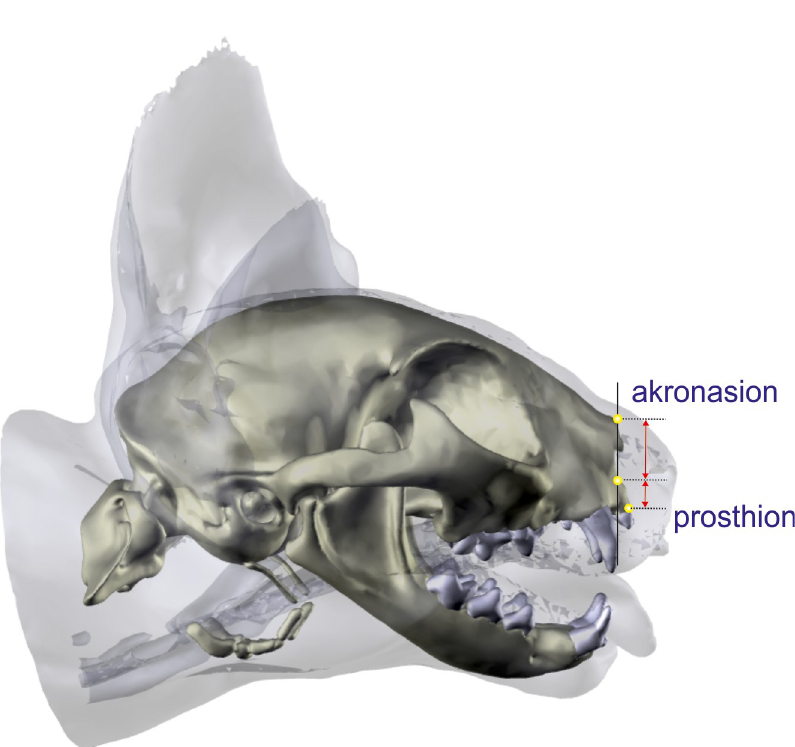
Fig 4. Measurements of the relative height of the bony nasal aperture. Three-dimensional reconstructions of a Domestic shorthair cat in a lateral view. The distance from the akronasion to the midpoint of the palatine process of the incisive bone compared with the distance from the prosthion to that point in the same plane to determine the relative height of the bony nasal aperture.